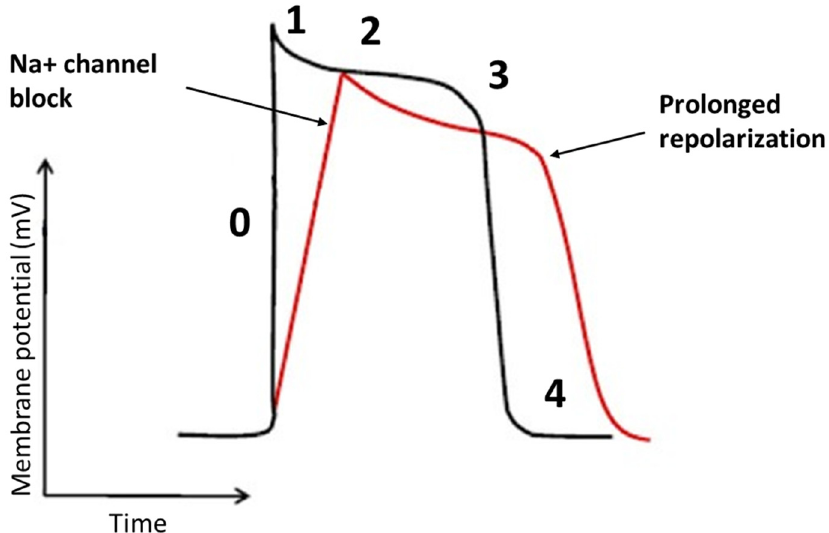
Figure 2. The effects of the flecainide on the cardiac action potential. The main effect of flecainide is a reduction in the slope of phase 0 with a minimal elongation of action potential.